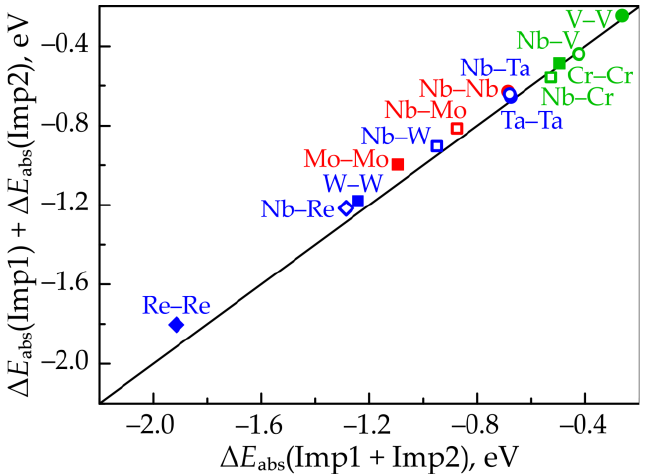
Figure 11. Comparison of Δ E abs (Imp1) + Δ E abs (Imp2) and Δ E abs (Imp1 + Imp2) values.